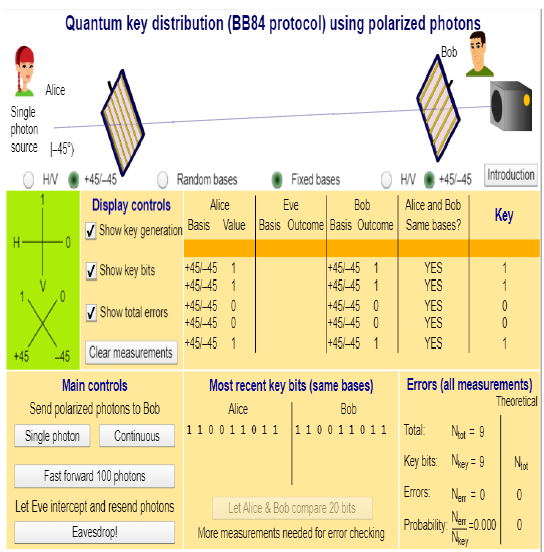
Figure 4. Extension of the Proposed Scheme